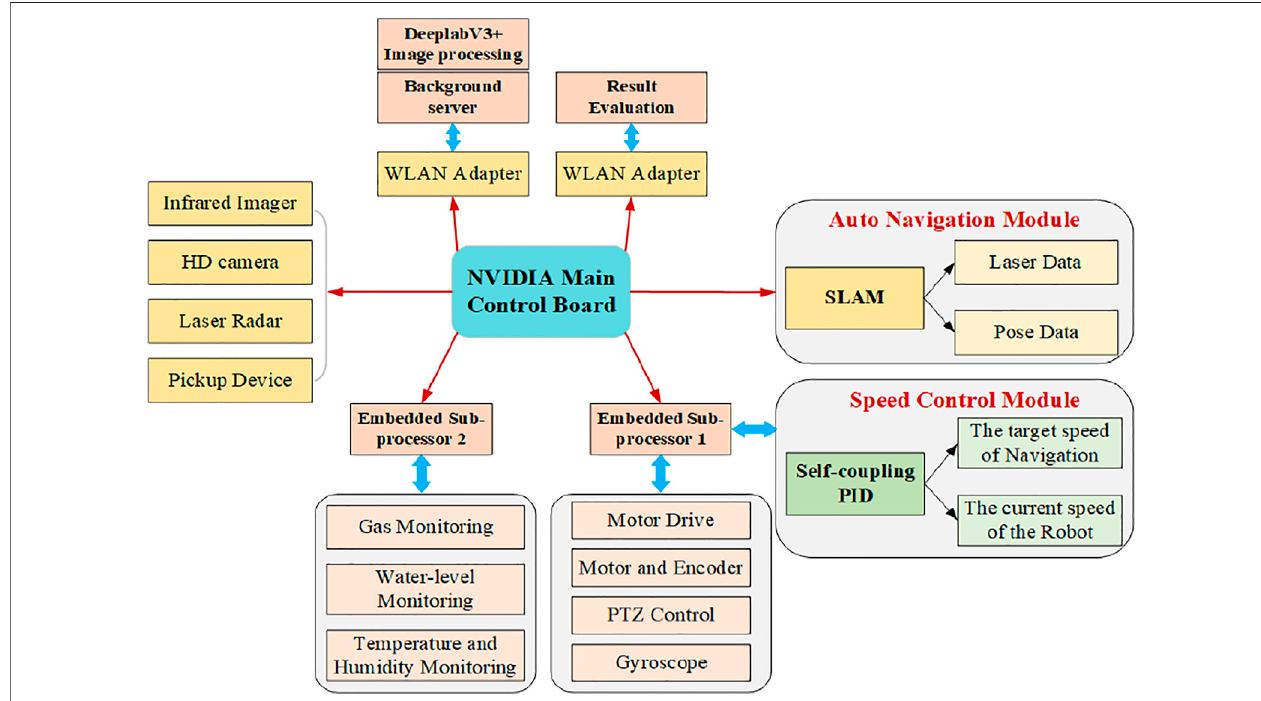
FIGURE 1 | System structure of the intelligent inspection robot for the cable